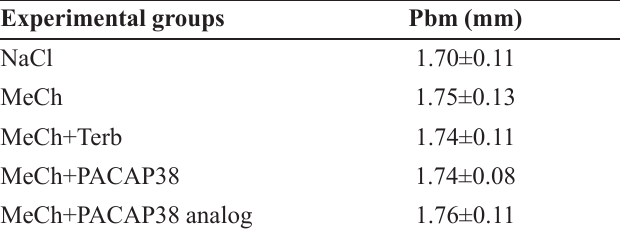
Airway sizes were determined by measuring basement membrane diameters (pbm). Values (means ±standard deviations, n=10 bronchi per animal (n=8)) are not significantly different (Tukey’s multiple comparison post hoc